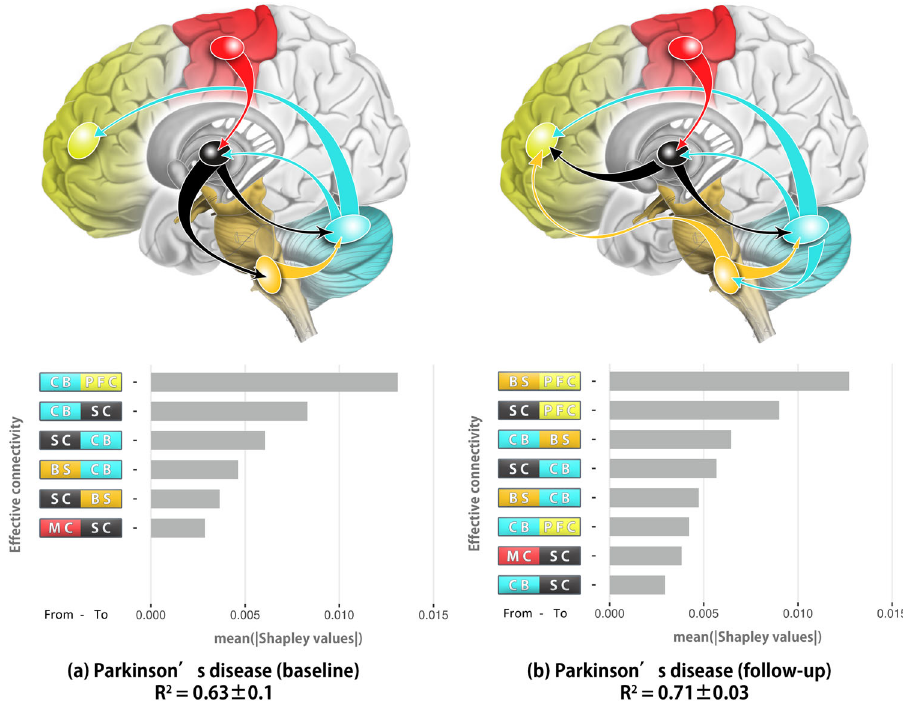
Fig. 6 Optimal SVR models for patients before and after treadmill training. a Optimal SVR model for patient group at baseline. b Optimal SVR model for patient group at follow-up. Feature contributions (gray bars) are listed below the corresponding model. PFC prefrontal cortex, MC motor cortex, BS brainstem, CB cerebellum, SC subcortical